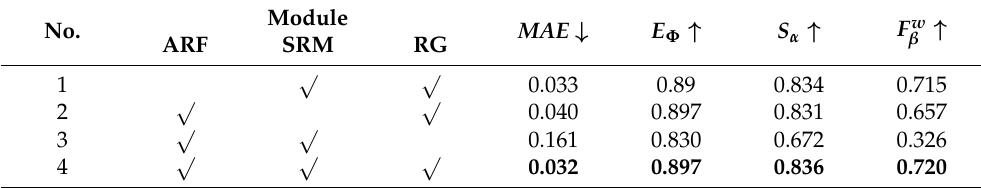
Table 3. Results of the effectiveness verification. The best results are highlighted in bold fonts.